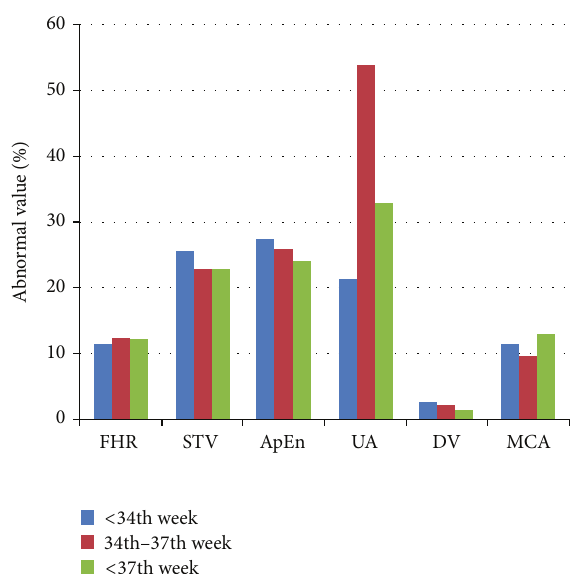
Figure 1: percentile of abnormal values in patients. UA, DV, and MCA are expressed as PI, pulsatility